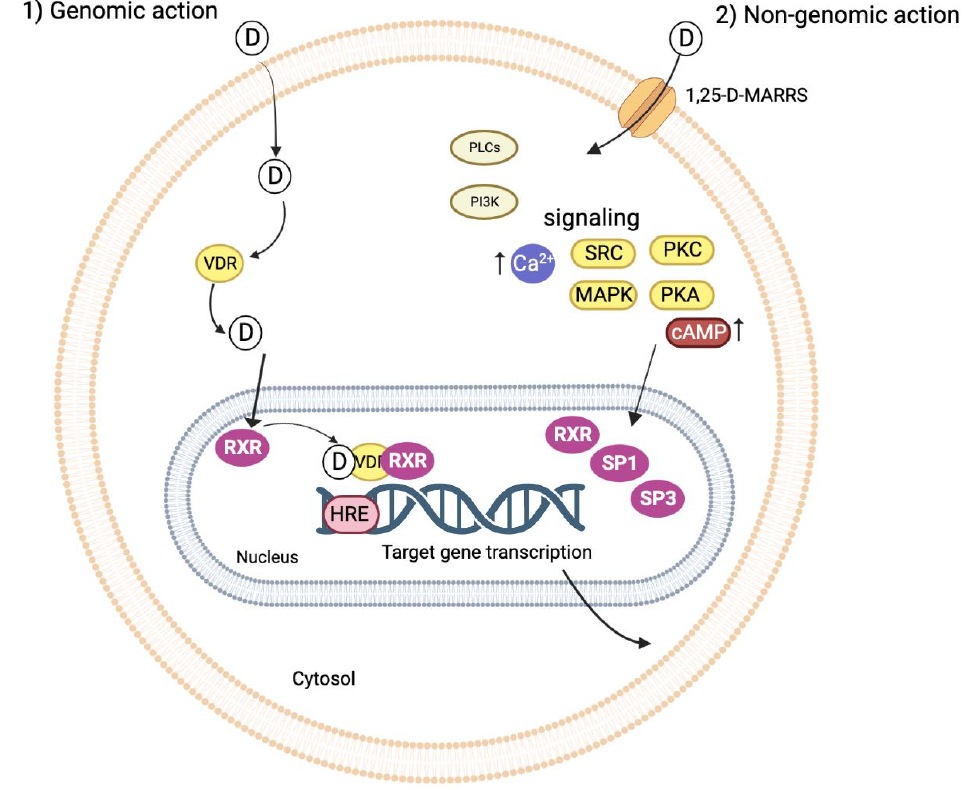
Figure 3. 1,25(OH) 2 D 3 genomic (1) and non-genomic (2) pathways. The VDR acts with other nuclear hormone receptors, especially the RXR [47]. 1,25(OH) 2 D 3 crosses the cell membrane and enters the nucleus, where it interacts with the VDR. The VDR/1,25(OH) 2 D complex translocates into the nu- cleus in a ligand-dependent fashion [48]. In the nucleus, the VDR/1,25(OH) 2 D generates an active signal transduction complex consisting of the heterodimer of the vitamin D-liganded VDR and the RXR. The VDR/RXR heterodimer recognizes the HRE in the DNA sequence of the vitamin D-regu- lated genes [46]. Here, regulation of gene expression in specific tissues mediated by the VDR occurs, evoking the (1) genomic response. (2) The non-genomic actions are mediated by binding of calcitriol to the membrane located 1,25-D-MARRS, which affects numerous intracellular cell signaling path- ways modulating the effects of gene expression through signal transduction to target transcription factors SP1, SP3, and RXR [51,52]. This figure was made using Biorender.com, agreement number